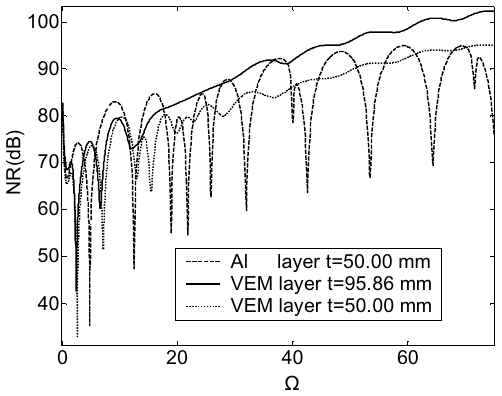
Fig. 8. Noise reduction for an aluminum cylinder with the thickness of 50 mm and a/b = 0.9 with various internal layers.